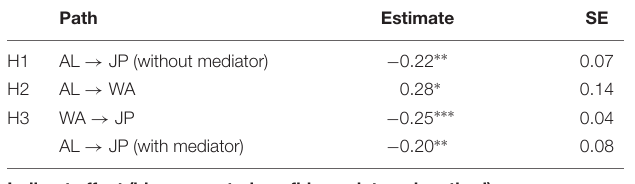
TABLE 4 | Moderation analysis.